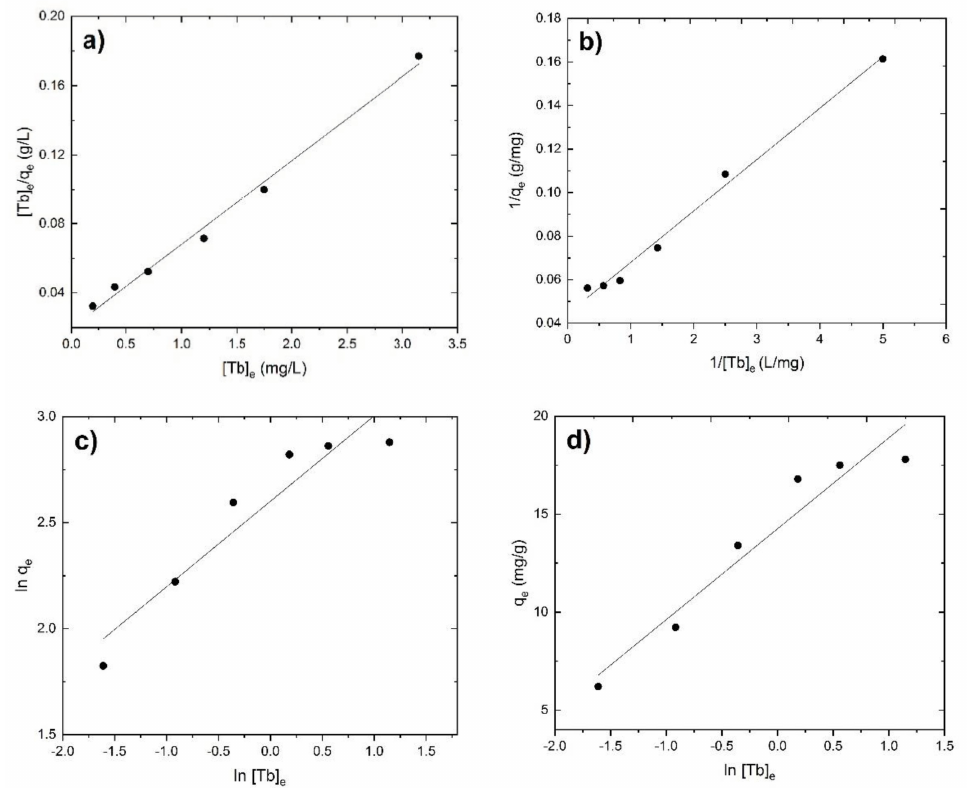
Figure 10. Fitting of ( a ) type-1 Langmuir, ( b ) type-2 Langmuir, ( c ) Freundlich, and ( d ) Temkin adsorption isotherm